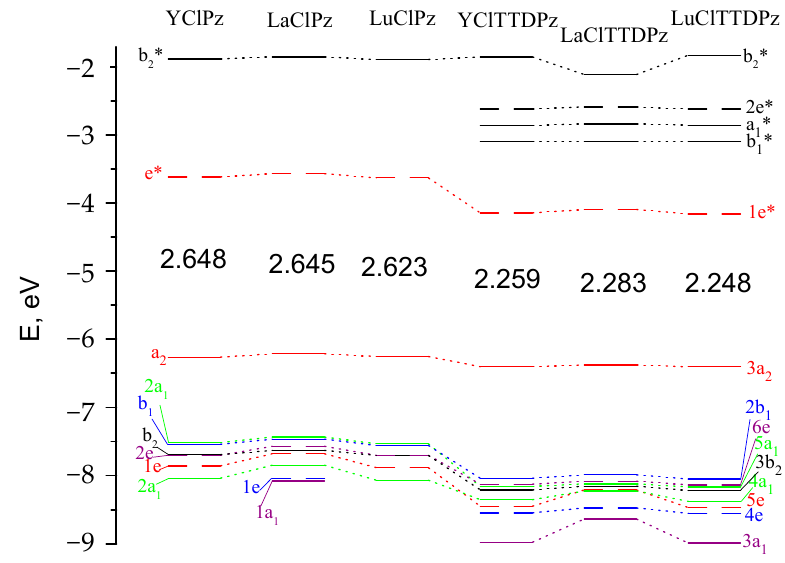
Figure 3. Molecular orbital (MO) level diagram for MClPz and MClTTDPz complexes. The values of highest occupied molecular orbital-lowest unoccupied molecular orbital (HOMO-LUMO) gaps are given in eV.